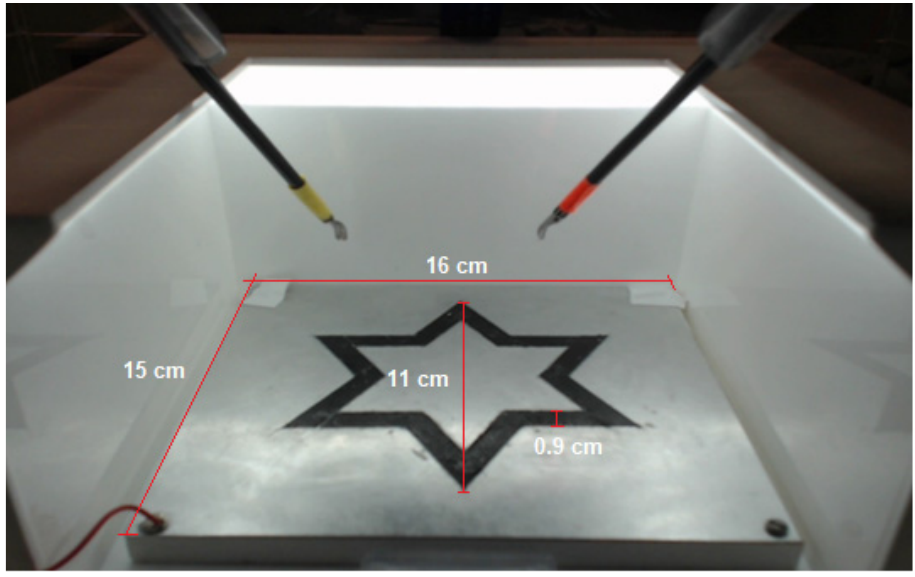
Figure 1. Star-track test (as seen in the box